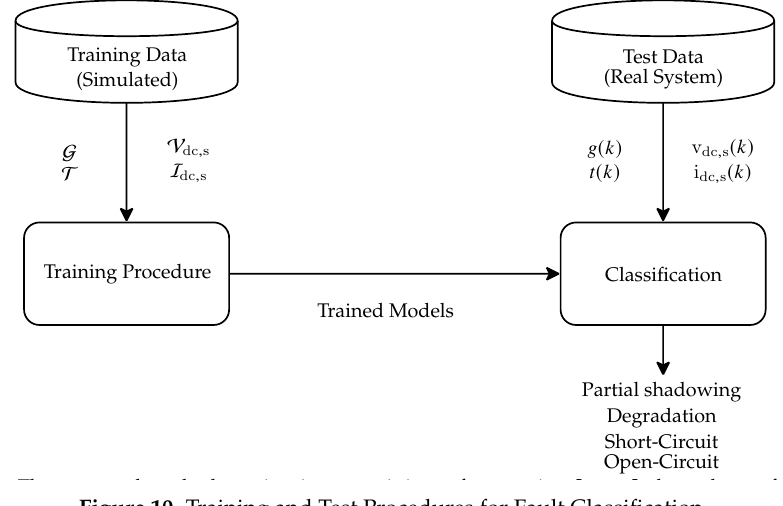
Figure 14: The proposed method consists in transmitting a frame using ⌈ α n cha ⌉ channel uses for the fi rst Figure 10. Training and Test Procedures for Fault transmission attempt, with 0 < α ≤ 1 . In the event of a decoding error, incremental redundancy is transmitted 1 − α n cha ⌋ channel uses. making use of the rest of the available ⌊ ( )